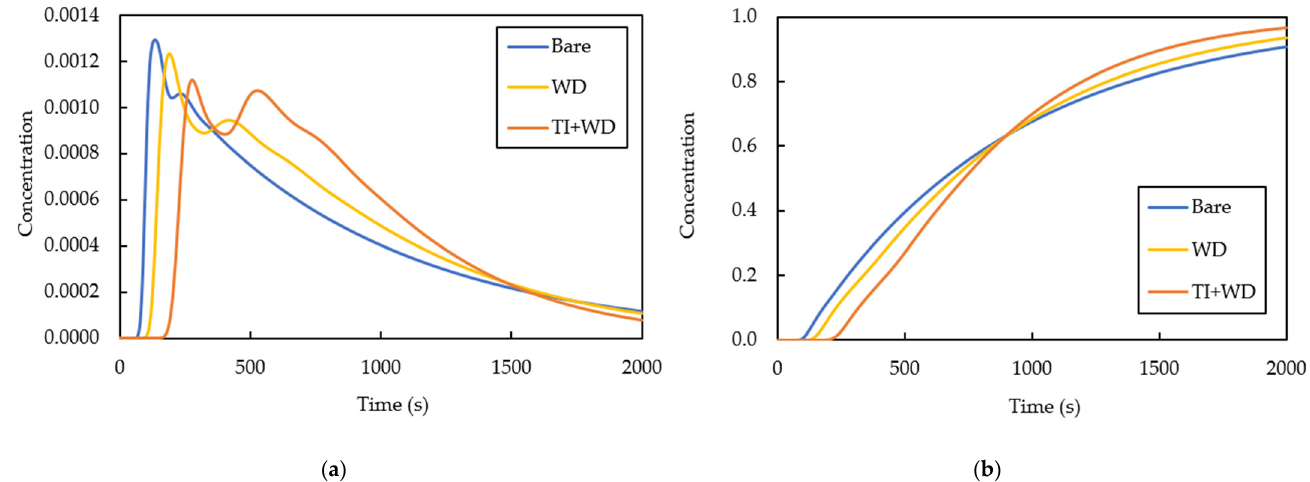
Figure 12. ( a ) E-curve and ( b ) F-curve for single-phase tundish configurations: bare, WD, and TI + WD. Table 4. Computational RTD parameters and the volume fraction of flow for Case bare, WD and TI + WD. Case